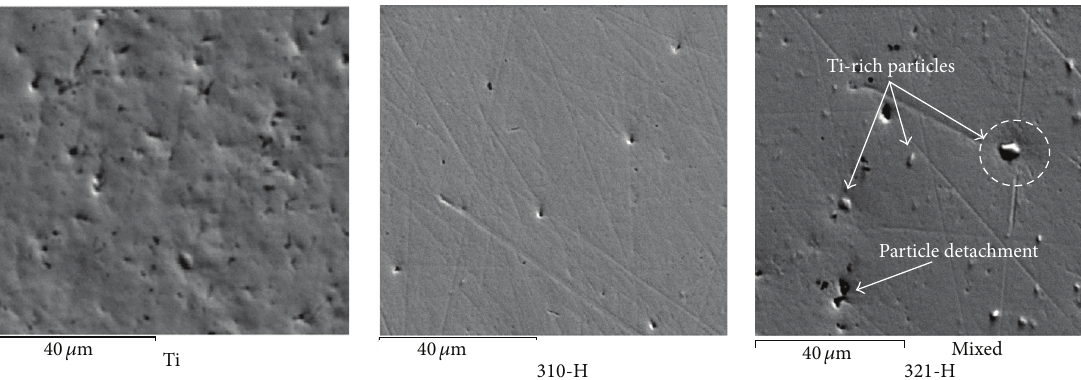
values for long time tests. corr